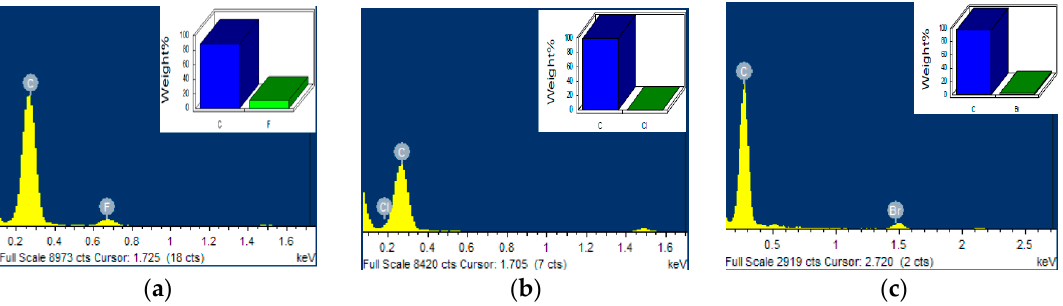
Figure 4. EDS spectra of ( a ) I − F , ( b ) I − Cl , and ( c ) I − Br . Inset shows the corresponding peaks associated with F, Cl, and Br elements.